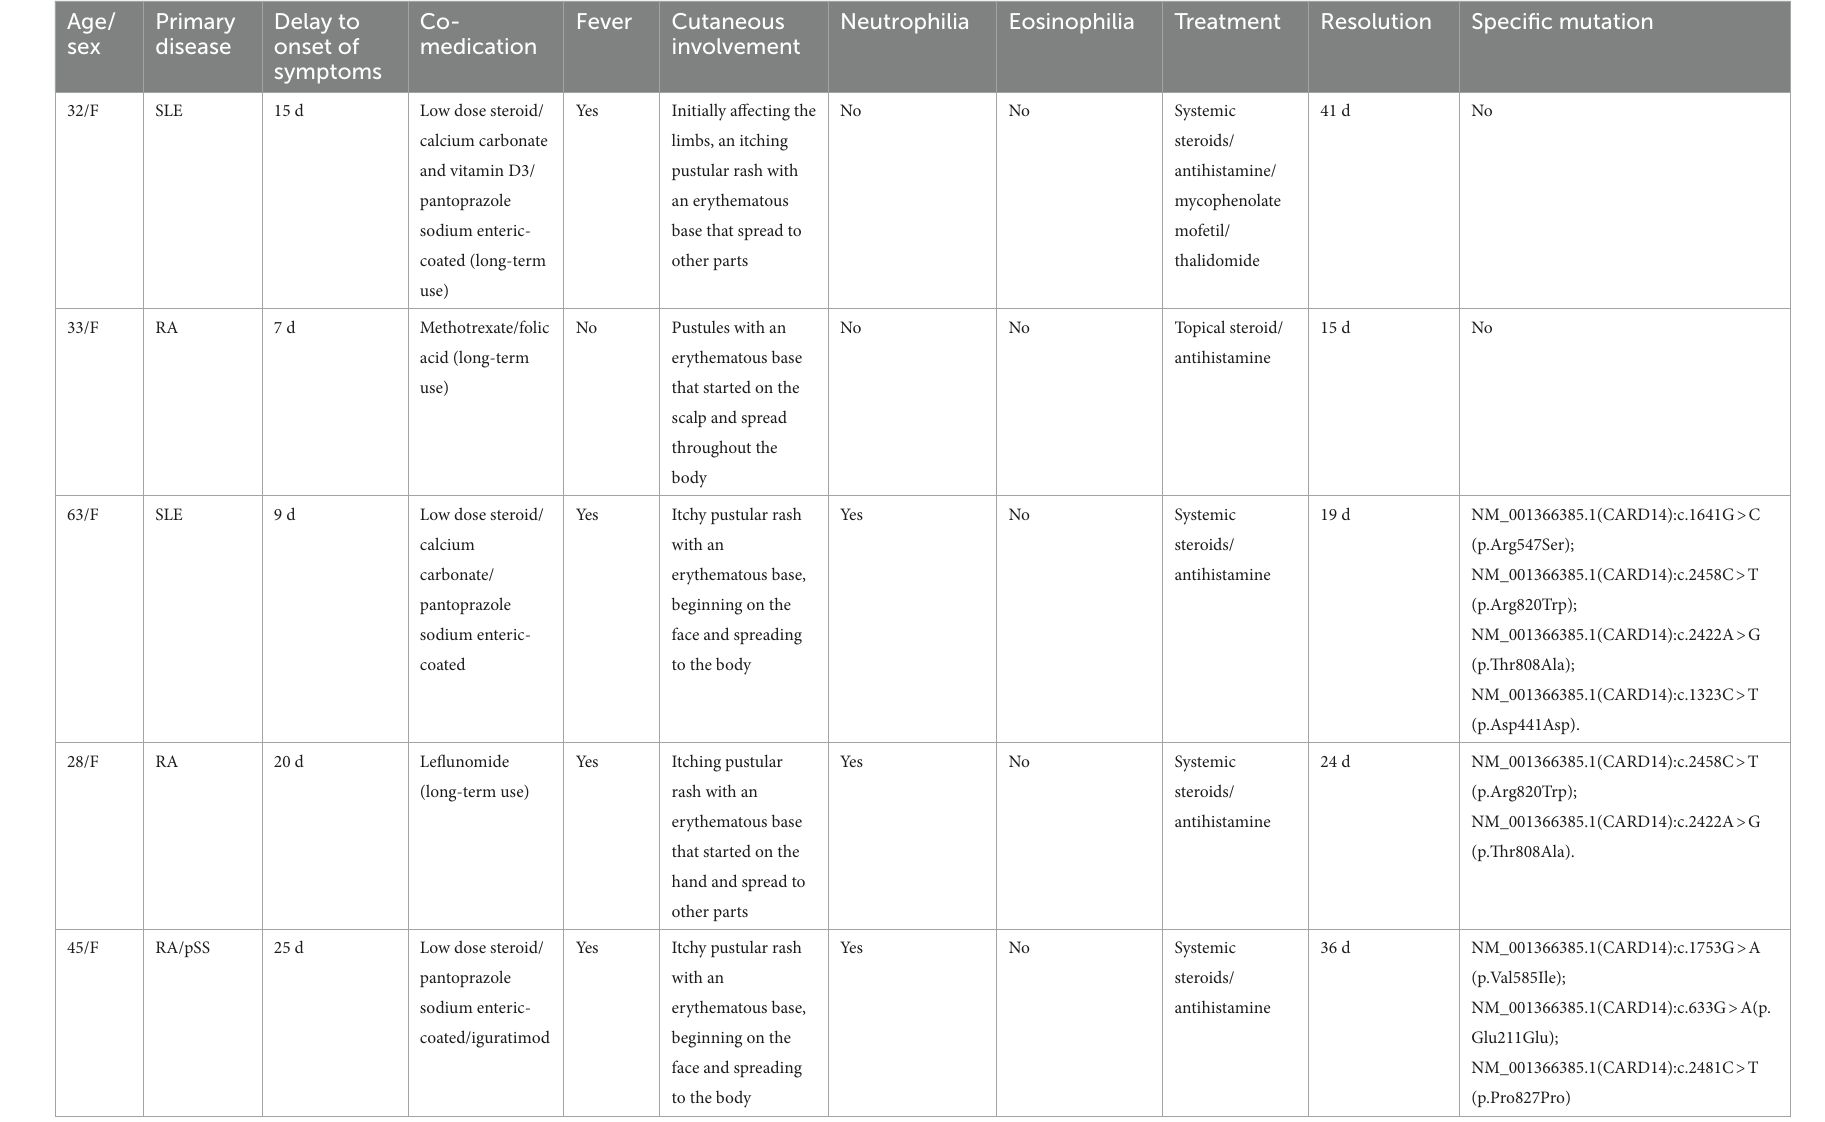
TABLE 1 Clinical characteristics, laboratory abnormalities, and allergological